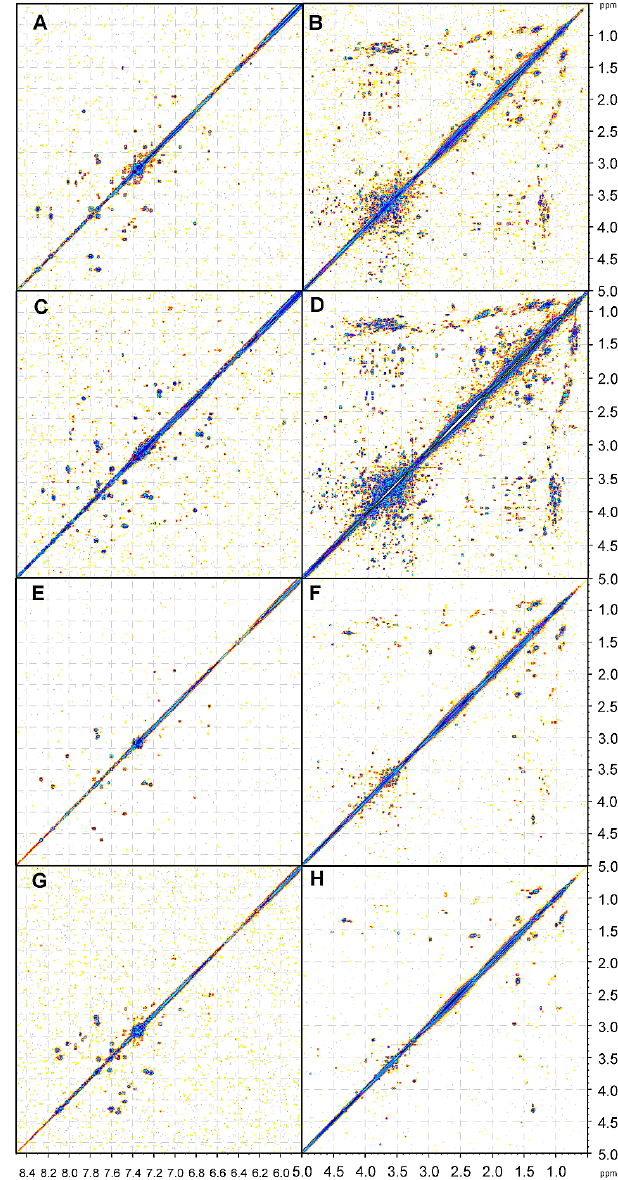
Fig. 6. 1 H, 1 HCOSYNMR spectra of marine SPE-DOM with (A, C, E, G) downfield ( δ H = 5.8–8.5ppm; aromatic and olefinic C- C H -C H -C cross peaks) and (B, D, F, H) upfield 1 HNMR sp 2 sp 2 chemical shift region ( δ H = 0.5–5.0ppm; aliphatic C- HC - HC -X (X: C, N, O) cross peaks; (A, B) 5m (near-surface photic zone); (C, D) 48m (fluorescence maximum); (E, F) 200m (upper mesopelagic zone); (G, H) 5446m (30m above